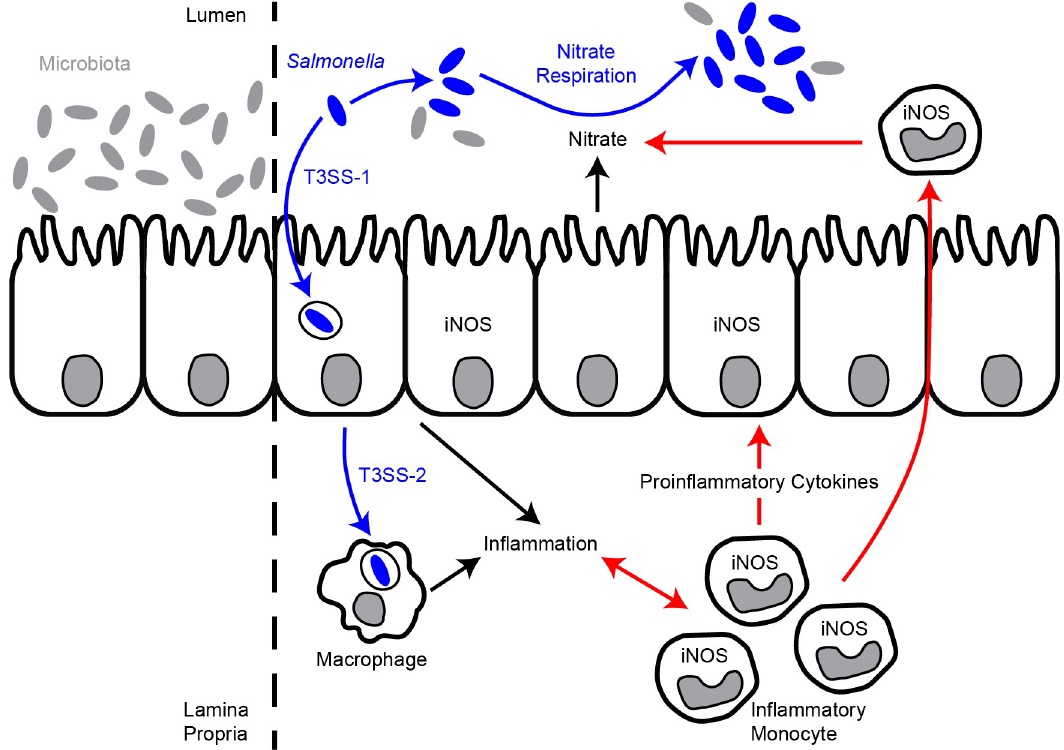
Fig 6. Model of how IM promote nitrate-dependent STm expansion in the lumen of the inflamed intestine. We postulate that IM contribute both directly and indirectly to the generation of host- derived nitrate used by STm for growth in the lumen of the inflamed intestine. IM may contribute directly to the generation of host-derived nitrate used by STm for growth in the lumen of the inflamed intestine by expressing Nos2 and indirectly by potentiating Nos2 expression by other cells such as IEC. See the text for